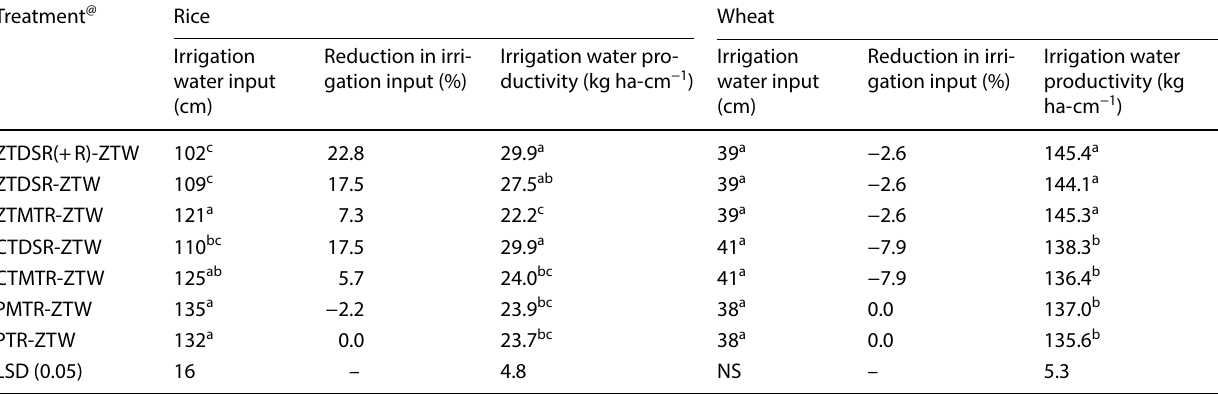
Table 5 Irrigation water input, reduction in irrigation input and irrigation water productivity in rice under different crop establishment methods continued since 2010–11 in the rice–wheat system (Average of 2010–11 to 2012–13)